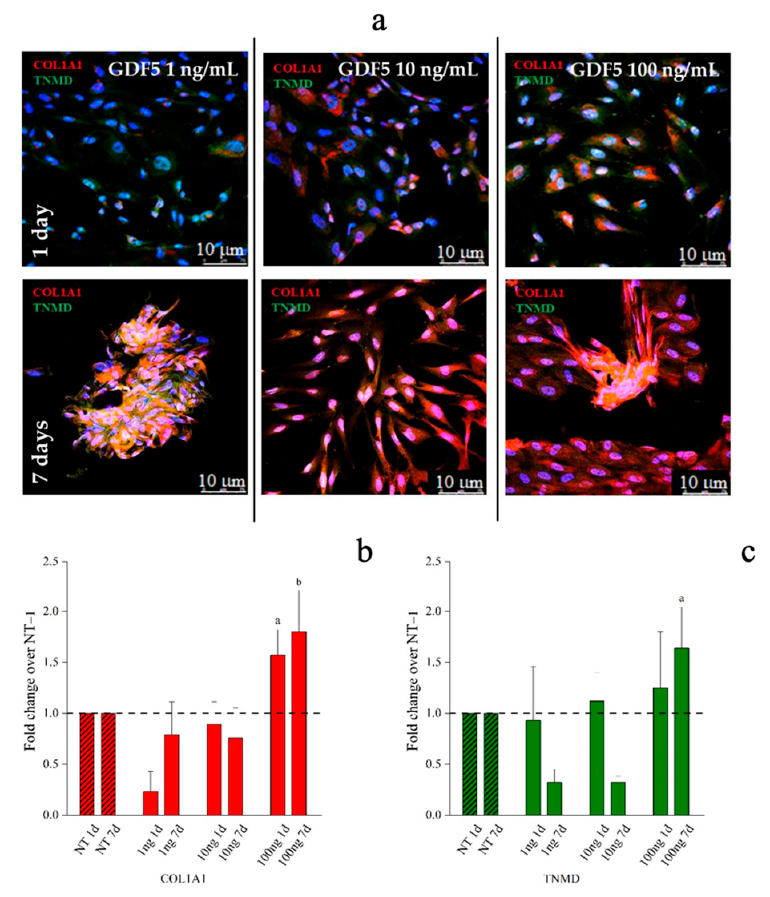
Figure 7. Immunofluorescence (IF) images and quantitative immunofluorescence (q-IF) data illustrating the effect of different hGDF-5 dose on hWJ-MSCs. The panel ( a ) shows type 1 collagen (red staining) and tenomodulin (green staining) proteins up to seven days of culture. Quantitative data on type 1 collagen ( b ) and tenomodulin ( c ) proteins were also reported; untreated cells (NT) are illustrated for comparison purpose. Statistically significant differences are shown as * = p ≤ 0.05; ** = p ≤ 0.01; *** = p ≤ 0.005; **** = p ≤ 0.001; a = p ≤ 0.05, b = p ≤ 0.01 compared to NT. (T0 = day 0; NT = untreated cells; 1ng = 1 ng/mL of hGDF-5; 10 ng = 10 ng/mL of hGDF-5; 100 ng = 100 ng/mL of hGDF-5; d = days).